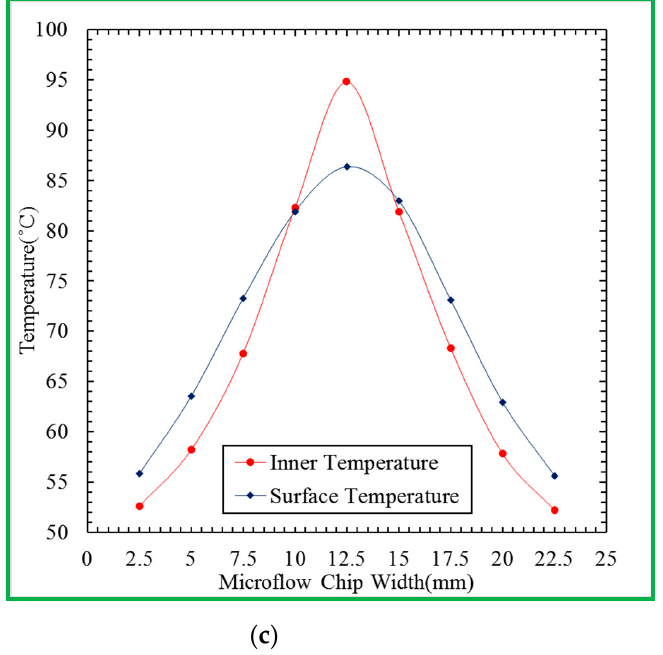
Figure 9. ( a ) The measured locations of the thermocouples at seventeen points. ( b ) The locations of the marked points at the annealing, extension, and nearby regions by the IR imager. ( c ) The measured temperatures lined at the same horizontal positions.